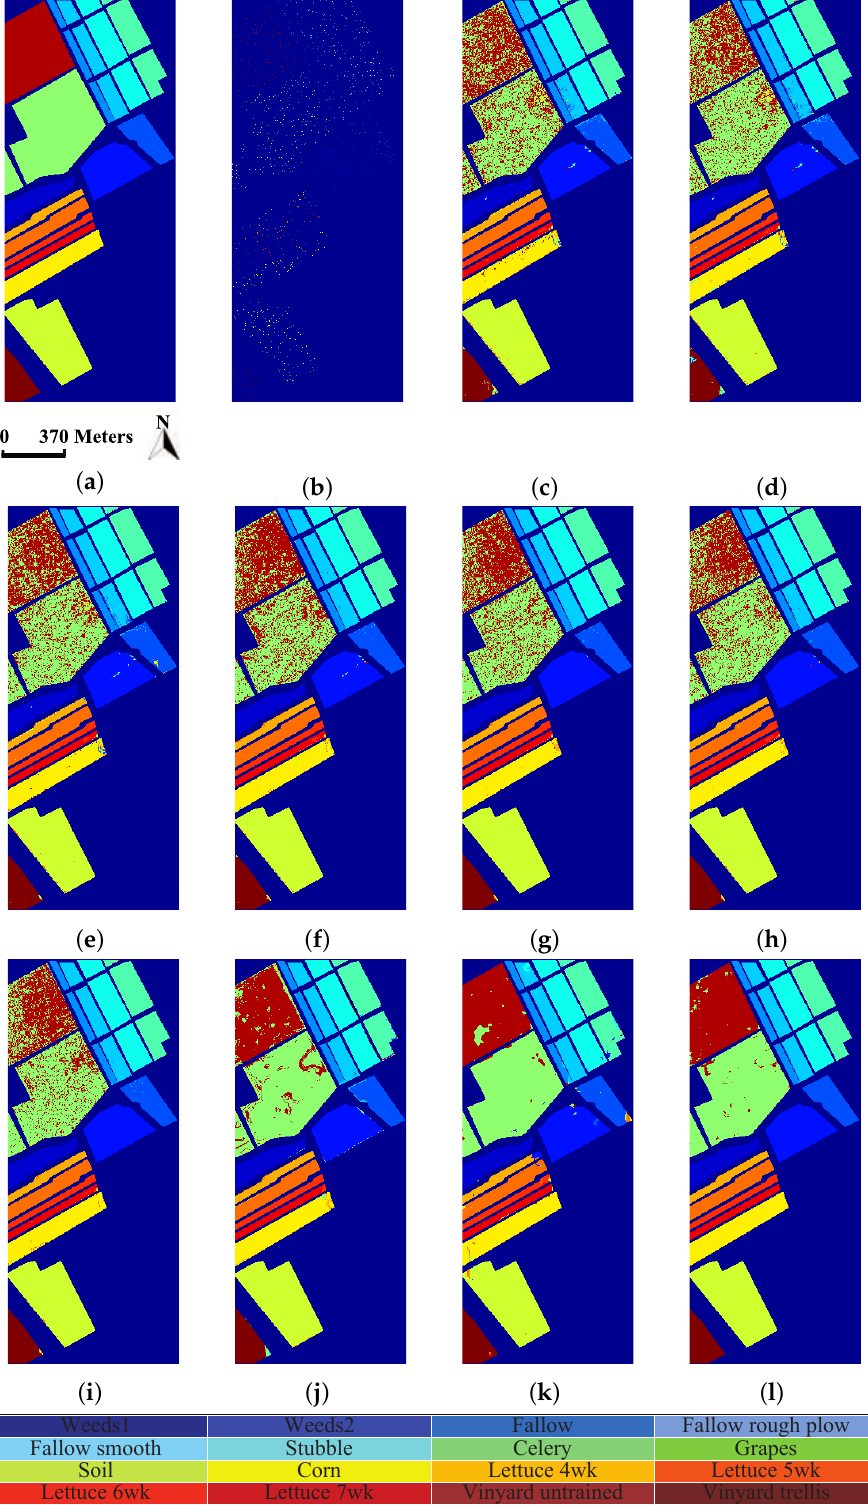
Figure 7. Classification maps of different methods for the Salinas dataset: ( a ) ground truth; ( b ) training set; ( c ) origin; ( d ) PCA; ( e ) LDA; ( f ) LFDA; ( g ) SGDA; ( h ) GDA-SS; ( i ) SLGDA; ( j ) MPCA; ( k ) G-LTDA; and ( l )